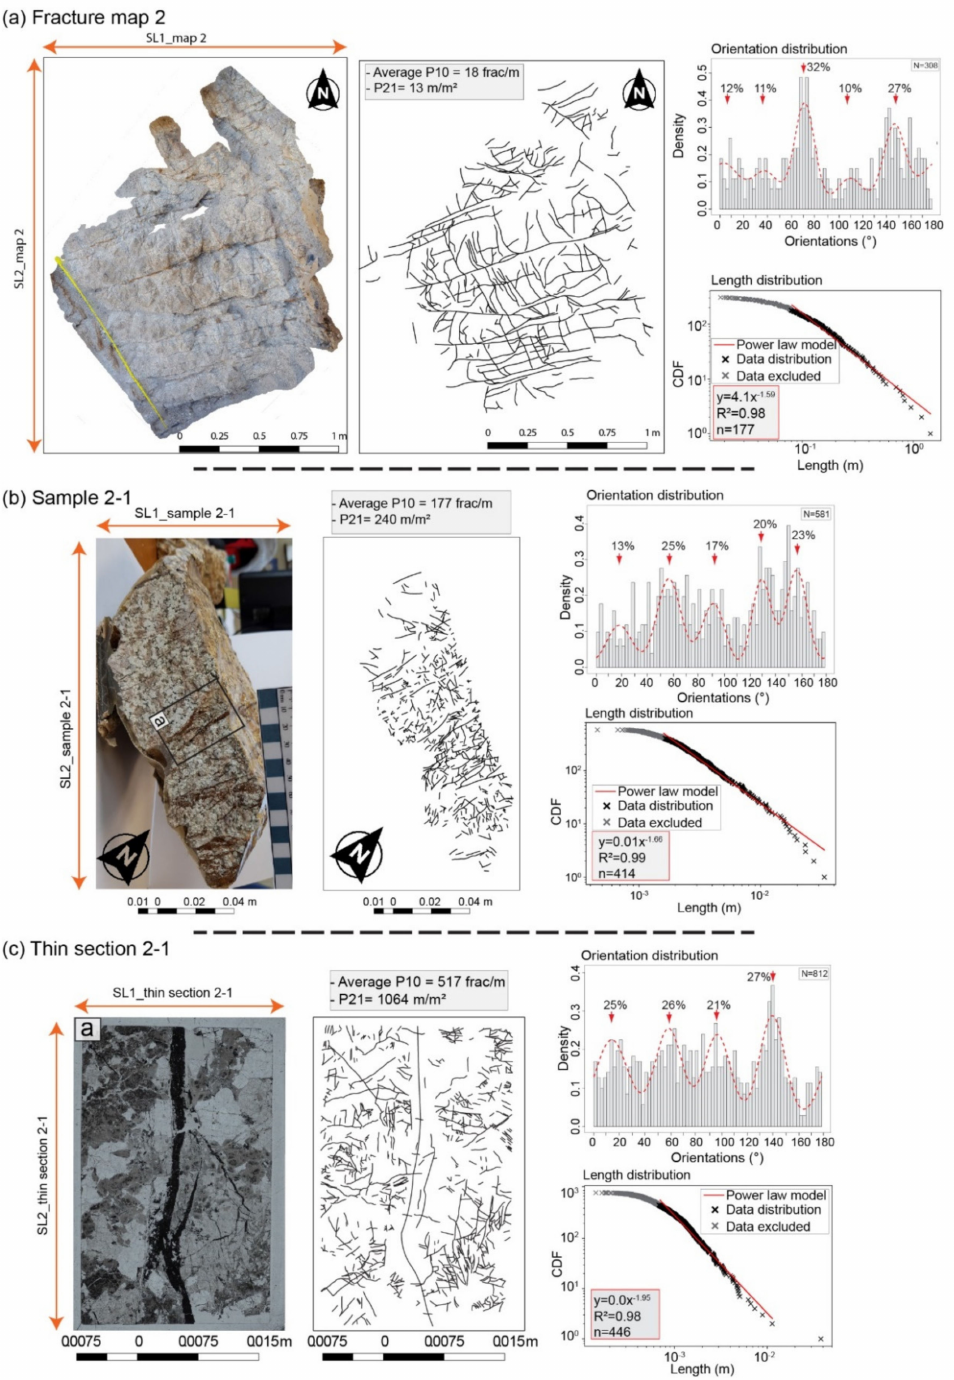
Figure 8. Fracture traces, orientation, and length distributions from ( a ) fracture map 2, ( b ) sample 2-1, and ( c ) thin section 2-1, located in sample 2-1. Different datasets are expressed into histogram for orientations distribution, and into cumulative distribution function (CDF) of lengths. Two scanlines (SL) were taken for each map. For orientation distribution legend, see Figure